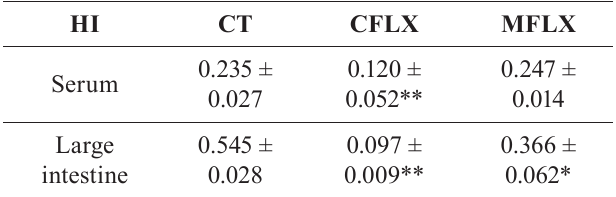
TABLE II - Effect of ciprofloxacin and moxifloxacin on HI of bile acids pool